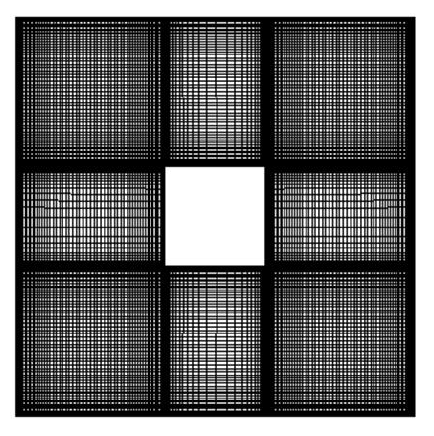
Figure 2. Non-uniform and structured mesh for computational domain